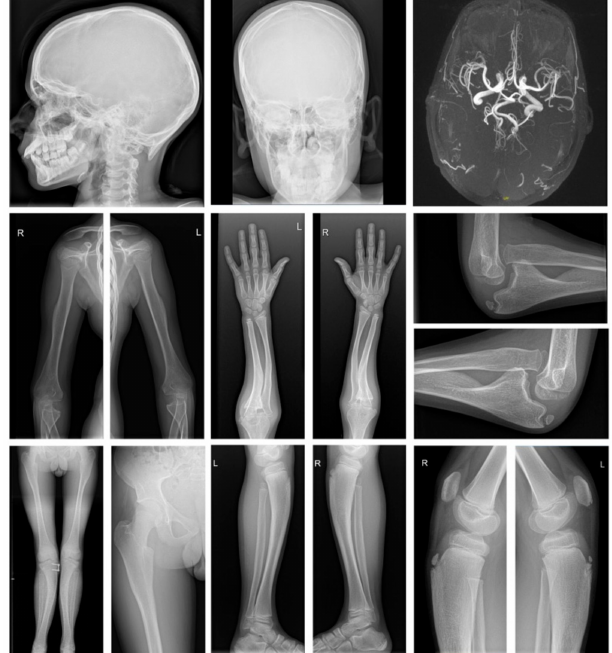
Figure 2. Total skeletal radiography and MRI / MRA studies in subject F1:II-1 showing severe skeletal dysplasia with occipital horns, undertubulation of bony structures and broadening of the ventral end of the first left rib, both claviculae and scapular neck, bowing of the long bones with mid-diaphyseal broadening, bilateral luxation of the radial heads, bilateral overgrowth of the ulnar coronoid processes, prominent trochanter minor of both femurs, short fibula, bilateral coxa valga with rounded iliac wings and broad metatarsals. Brain MRI and angiography showed tortuous intracranial arteries and normal brain